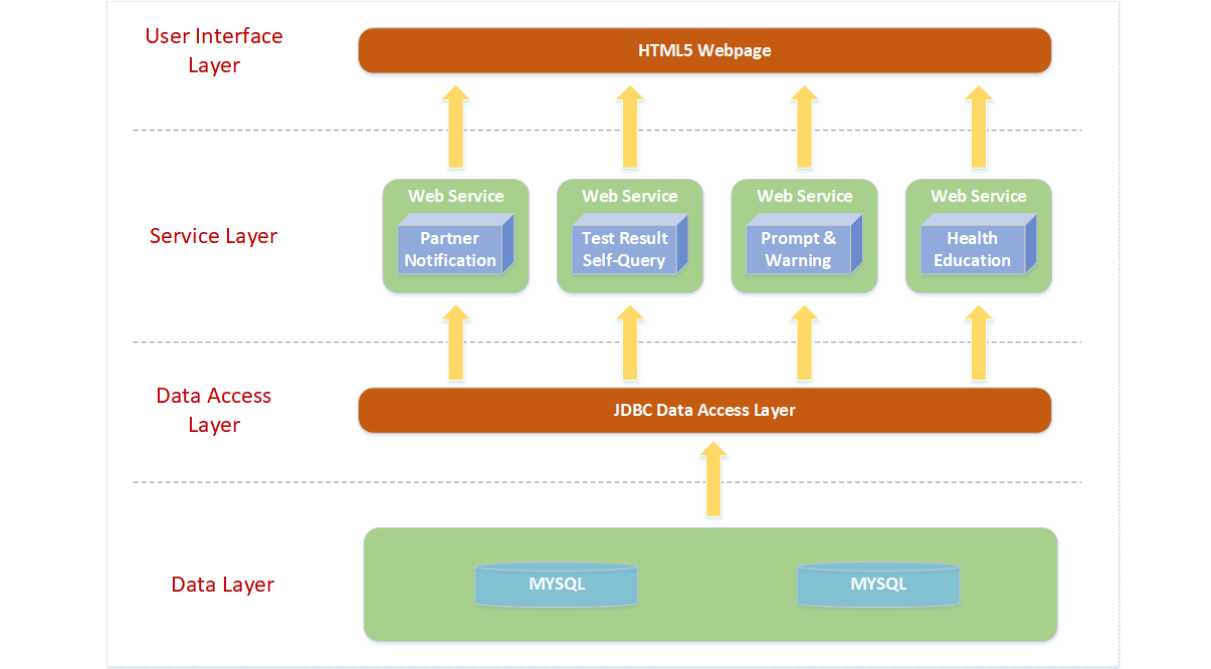
Figure 1. Application architecture. JDBC: Java Database Connectivity; SQL: Structured Query